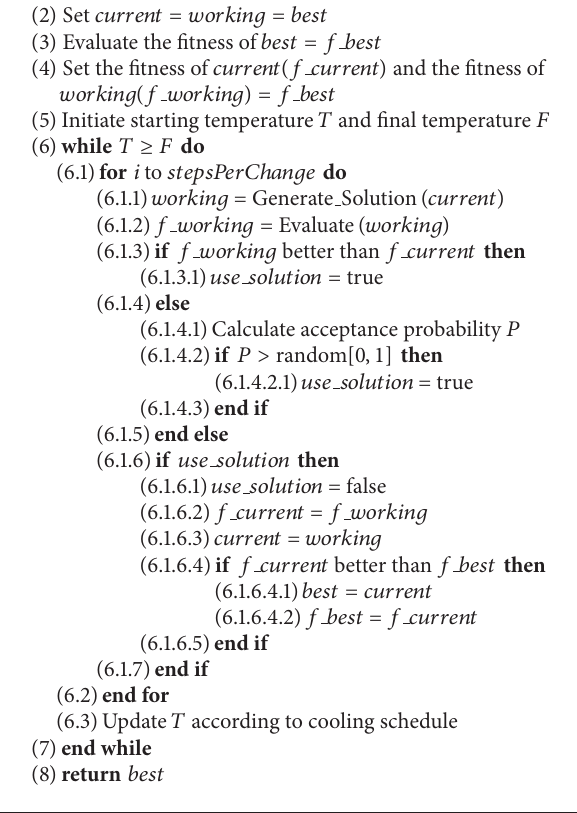
Table 3: Nonheuristic specific parameters required for the execu- tion of the algorithms.